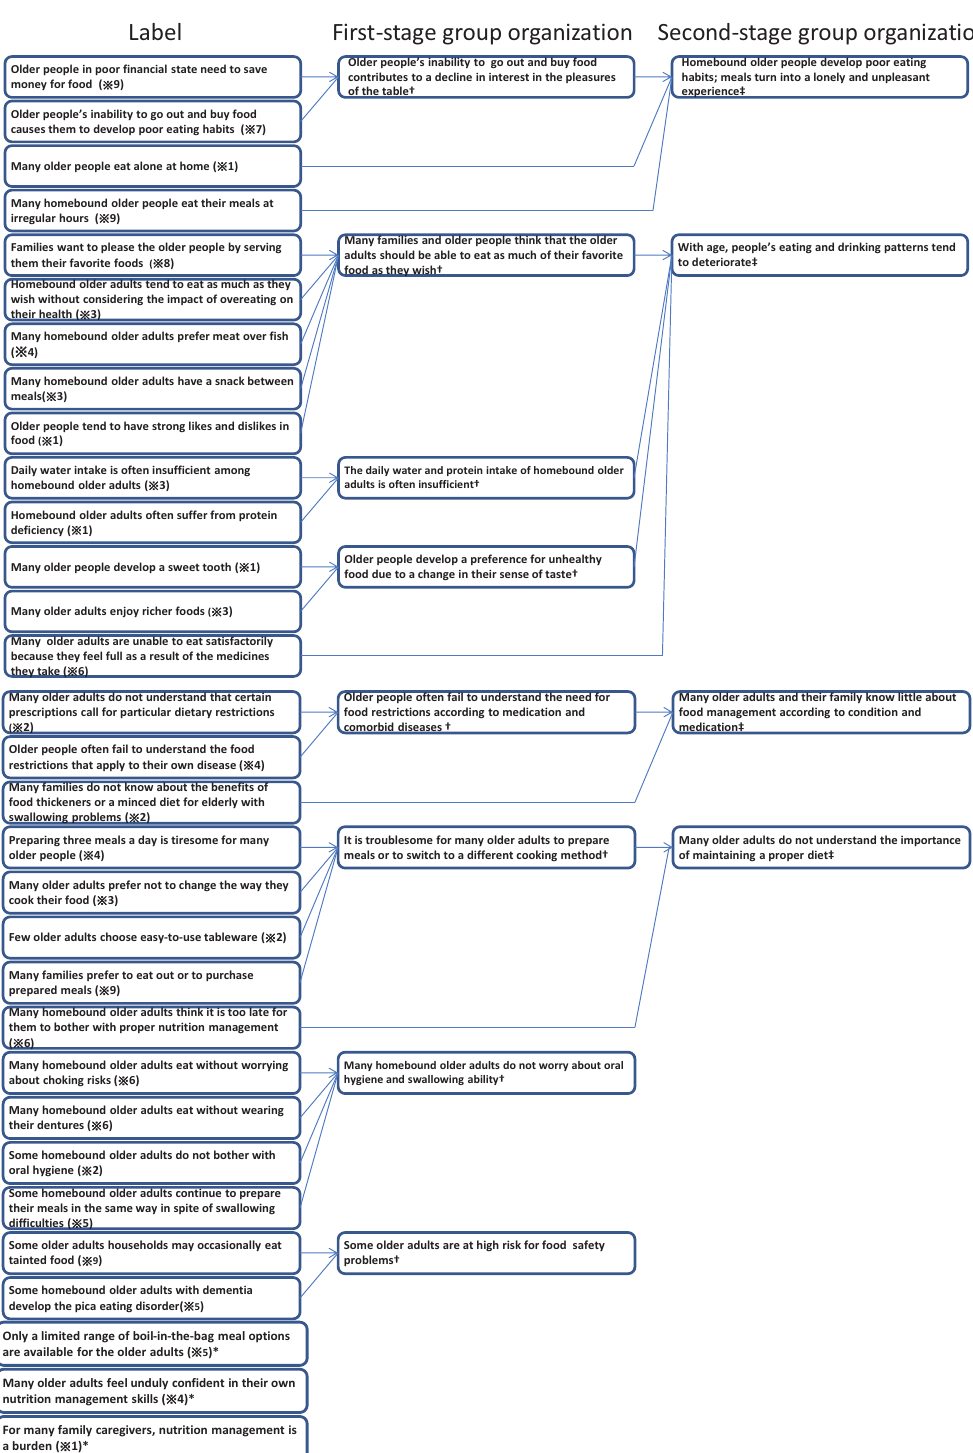
Figure 2. Flowchart of group